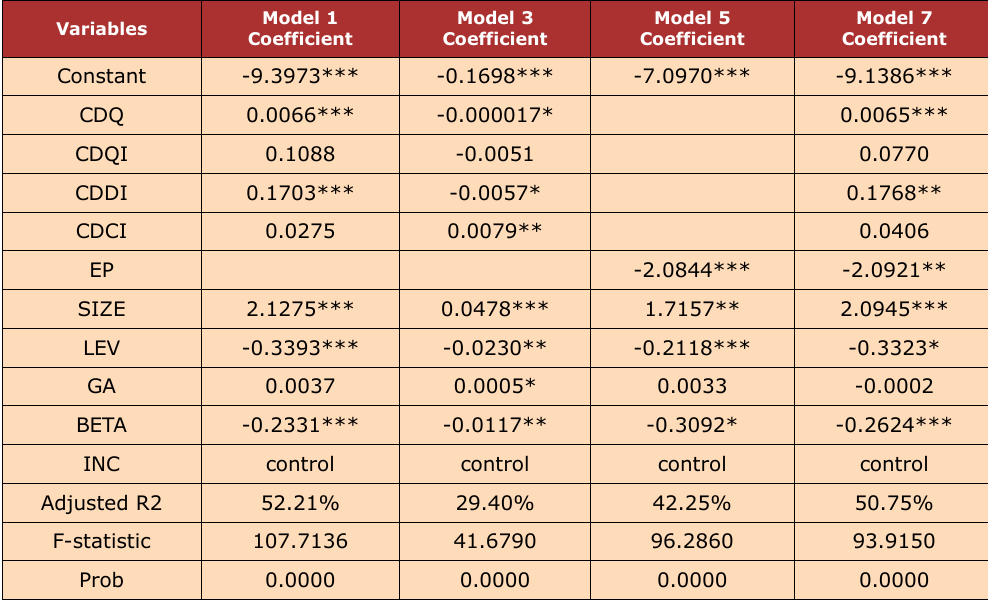
Table 5. Results of the mediating role of cost of equity